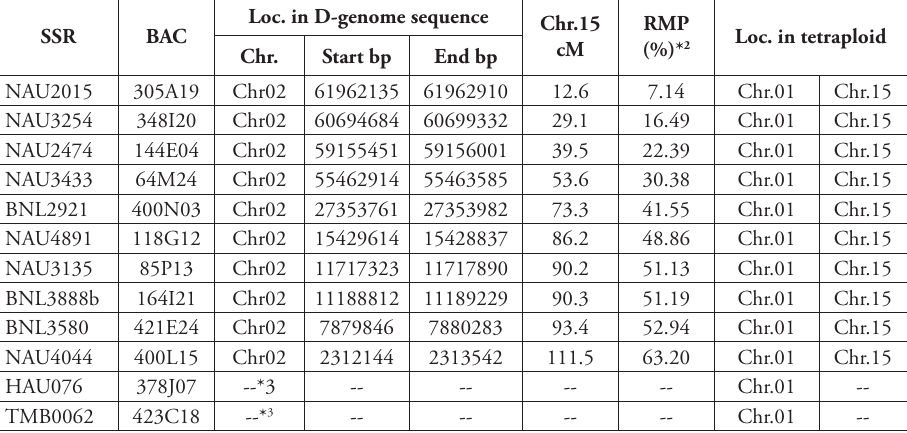
Table 1. Information of selected SSR markers based on the WGMM*